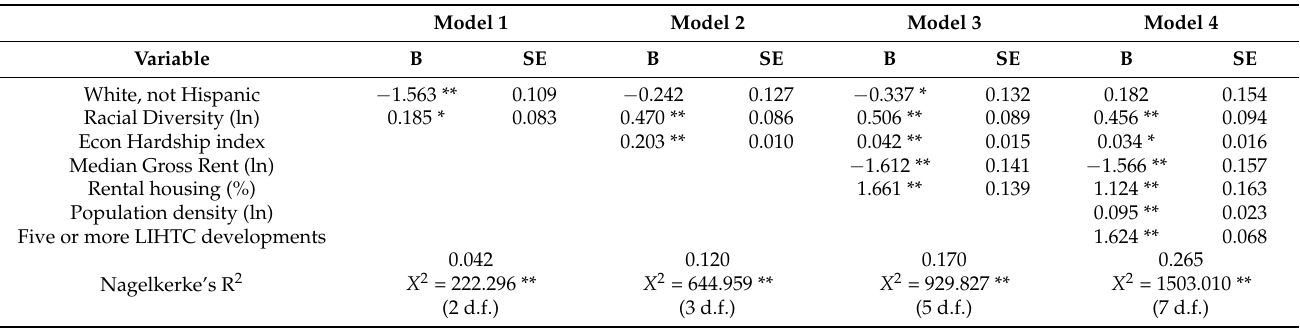
Table 5. Logistic Regression Results for California as a